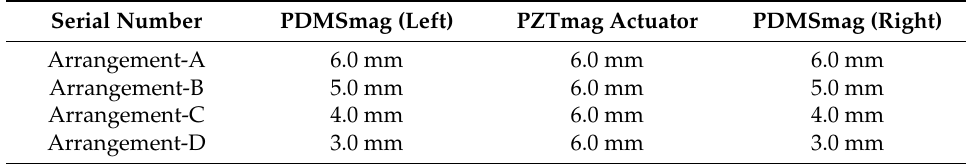
Table 1. Arrangement of active and passive magnets (diameter: